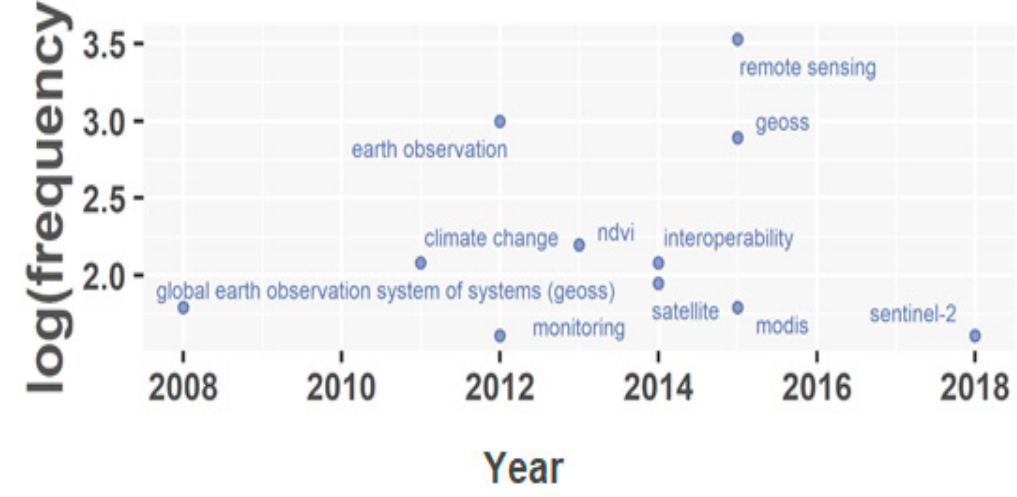
Figure 7. Decadal trending topics on EOS and PM studies.